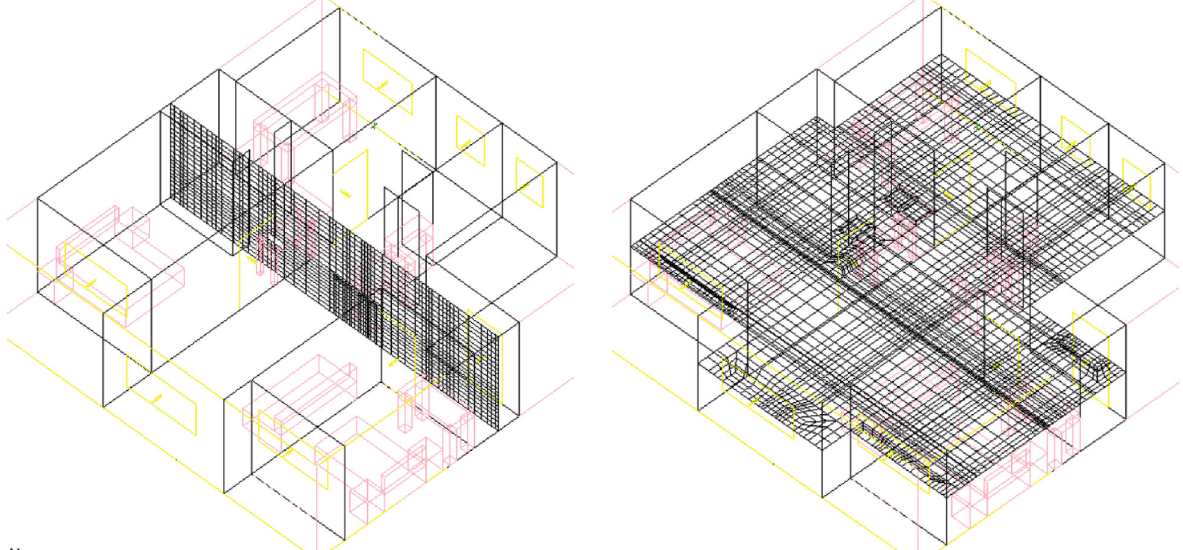
Figure 3: Grid division of house type A along the (a) X axis and (b) Y